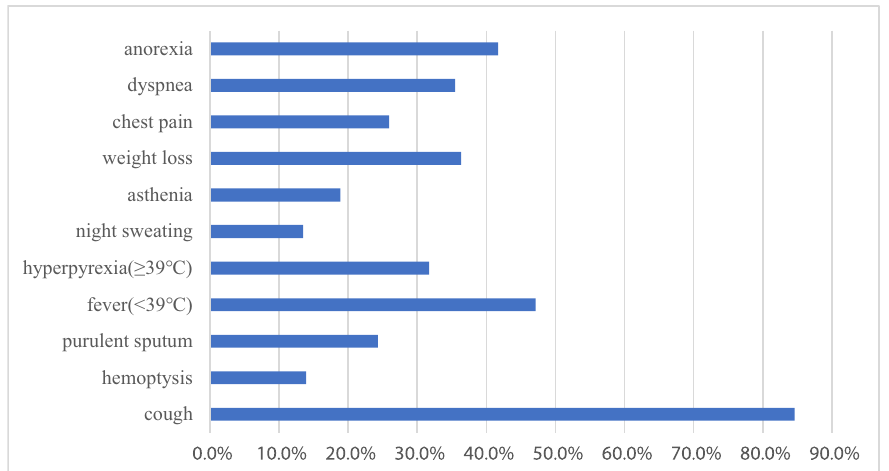
Figure 2: The frequency of symptoms. Symptoms varied widely in patients with atypical pulmonary tuberculosis mimicking bacteria pneumonia. The most common symptom reported was cough ( 84.6% ) , while the least common symptom was night sweating ( 13.5% )